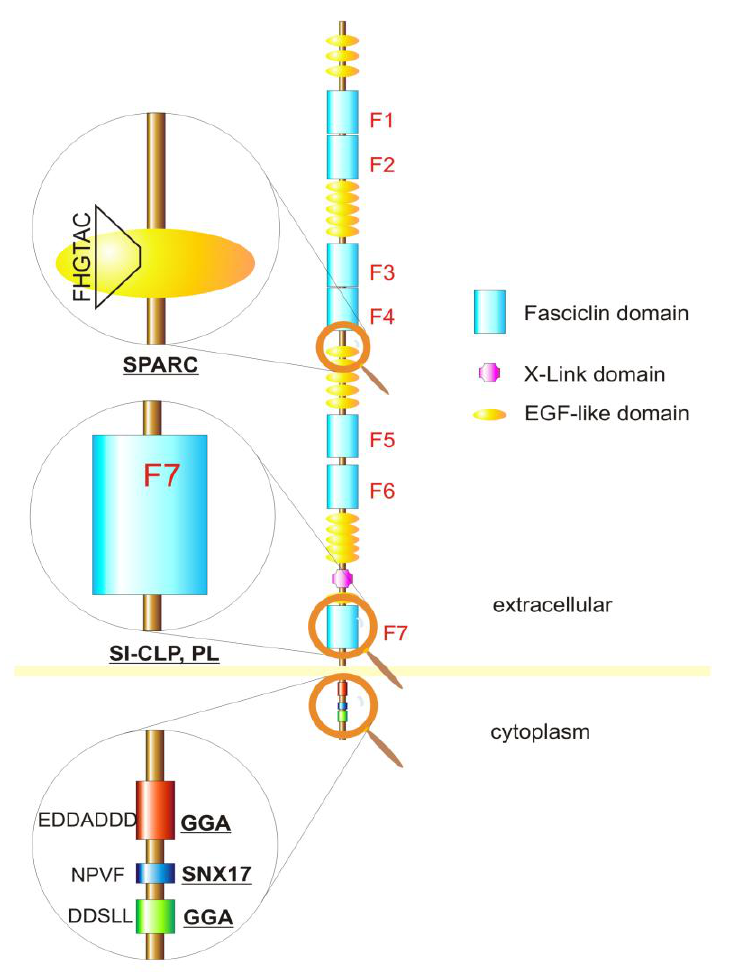
FIGURE 1. Stabilin-1 domain organization, binding sites for the ligands, and sorting adaptors. The large extracellular fragment of stabilin-1 is composed of seven fasciclin domains (blue cylinders F1–F7) and multiple EGF-like domains (yellow ovals). The X- link domain is shown in pink. SPARC (secreted protein acidic and rich in cysteine) binds to the EGF-like domain located between F4 and F5; the FHGTAC sequence was identified as SPARC-binding peptide in phage display. The chitinase-like protein SI- CLP and placental lactogen bind to F7. The short cytoplasmic tail contains a classical DDSLL motif and novel acidic cluster EDDADDD interacting with intracellular sorting adaptors – GGA1, GGA2, and GGA3L, as well as the NPVF site interacting with sorting nexin 17 (SNX17). Names of proteins that bind stabilin-1 are